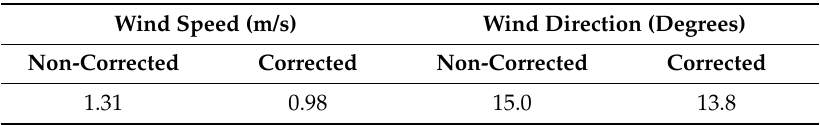
Table 2. Standard deviation of corrected and non-corrected values of wind speed and wind direction computed on the 61 flight sequences by